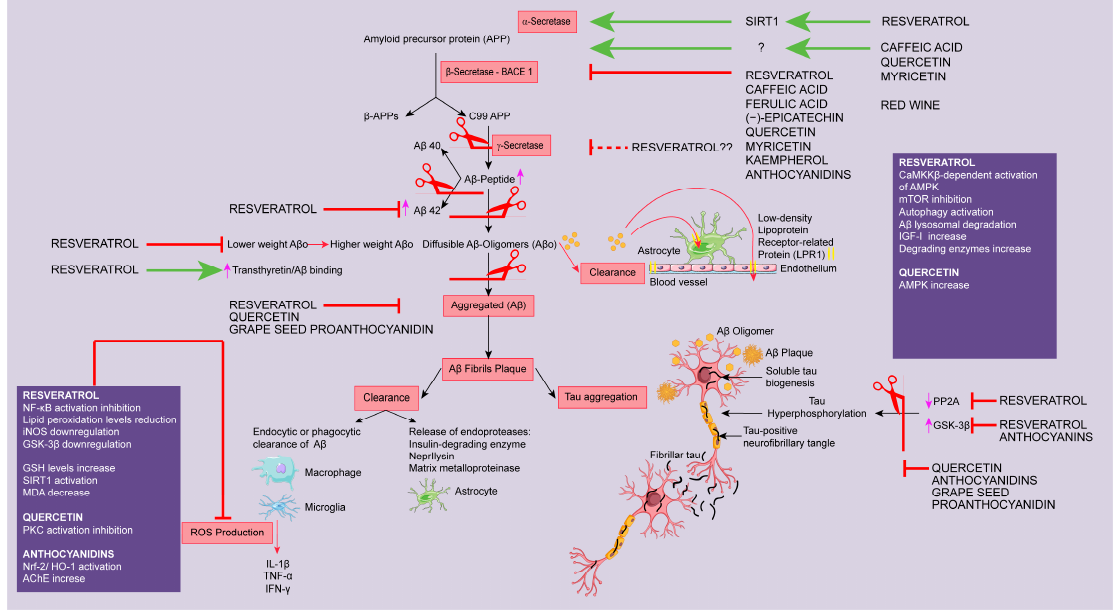
Figure 4. Effects of wine polyphenols on signaling pathways involved in Alzheimer’s disease pathology.